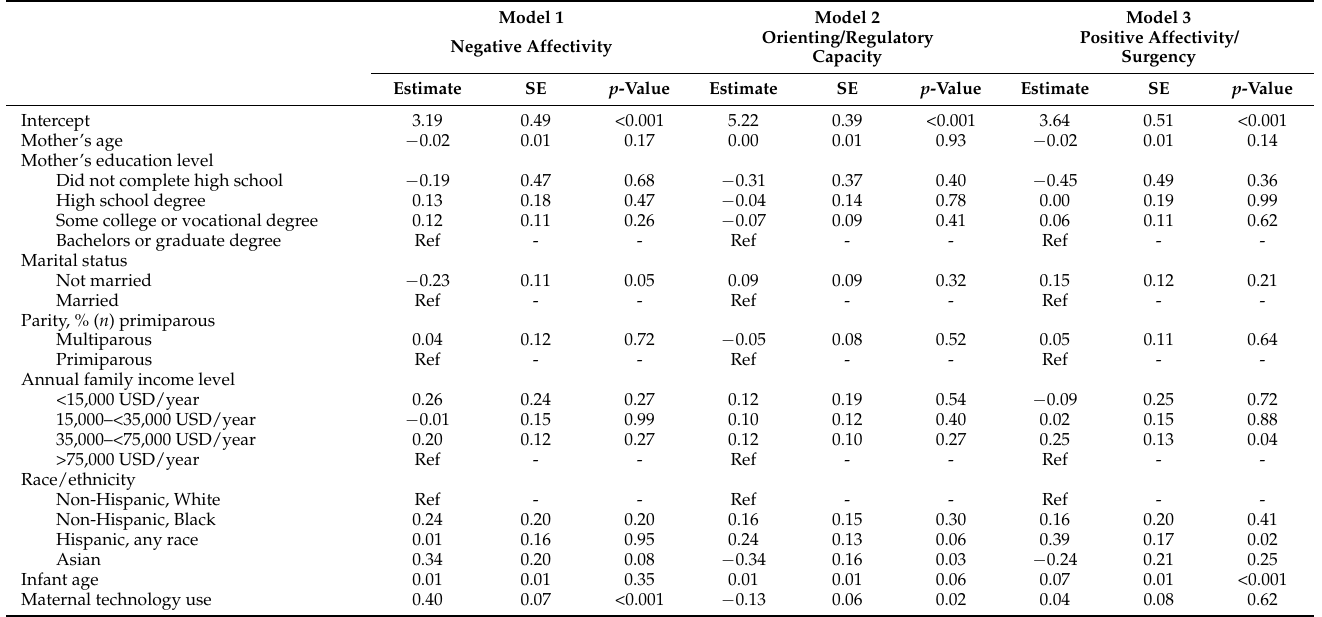
Table 2. Associations between maternal technology use during infant feeding and care and dimen- sions of infant temperament.